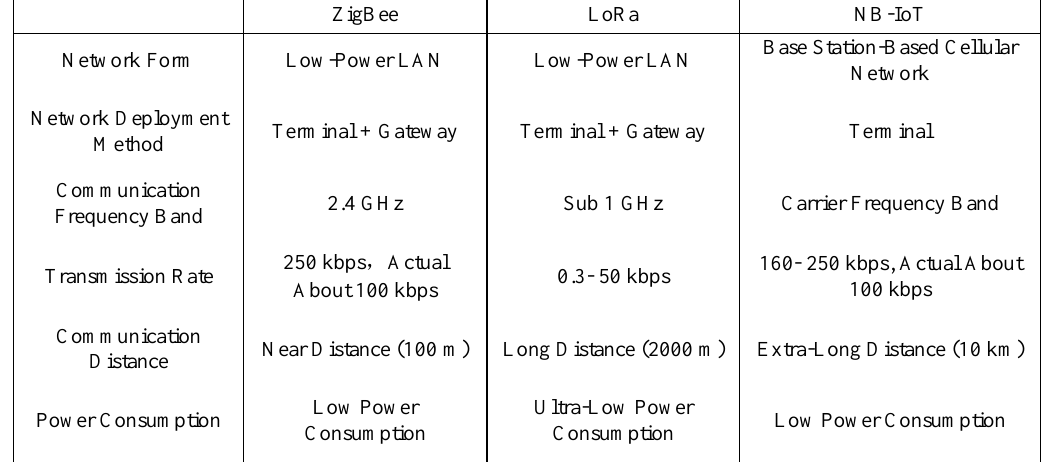
Table 1. Three types of communication technology characteristics